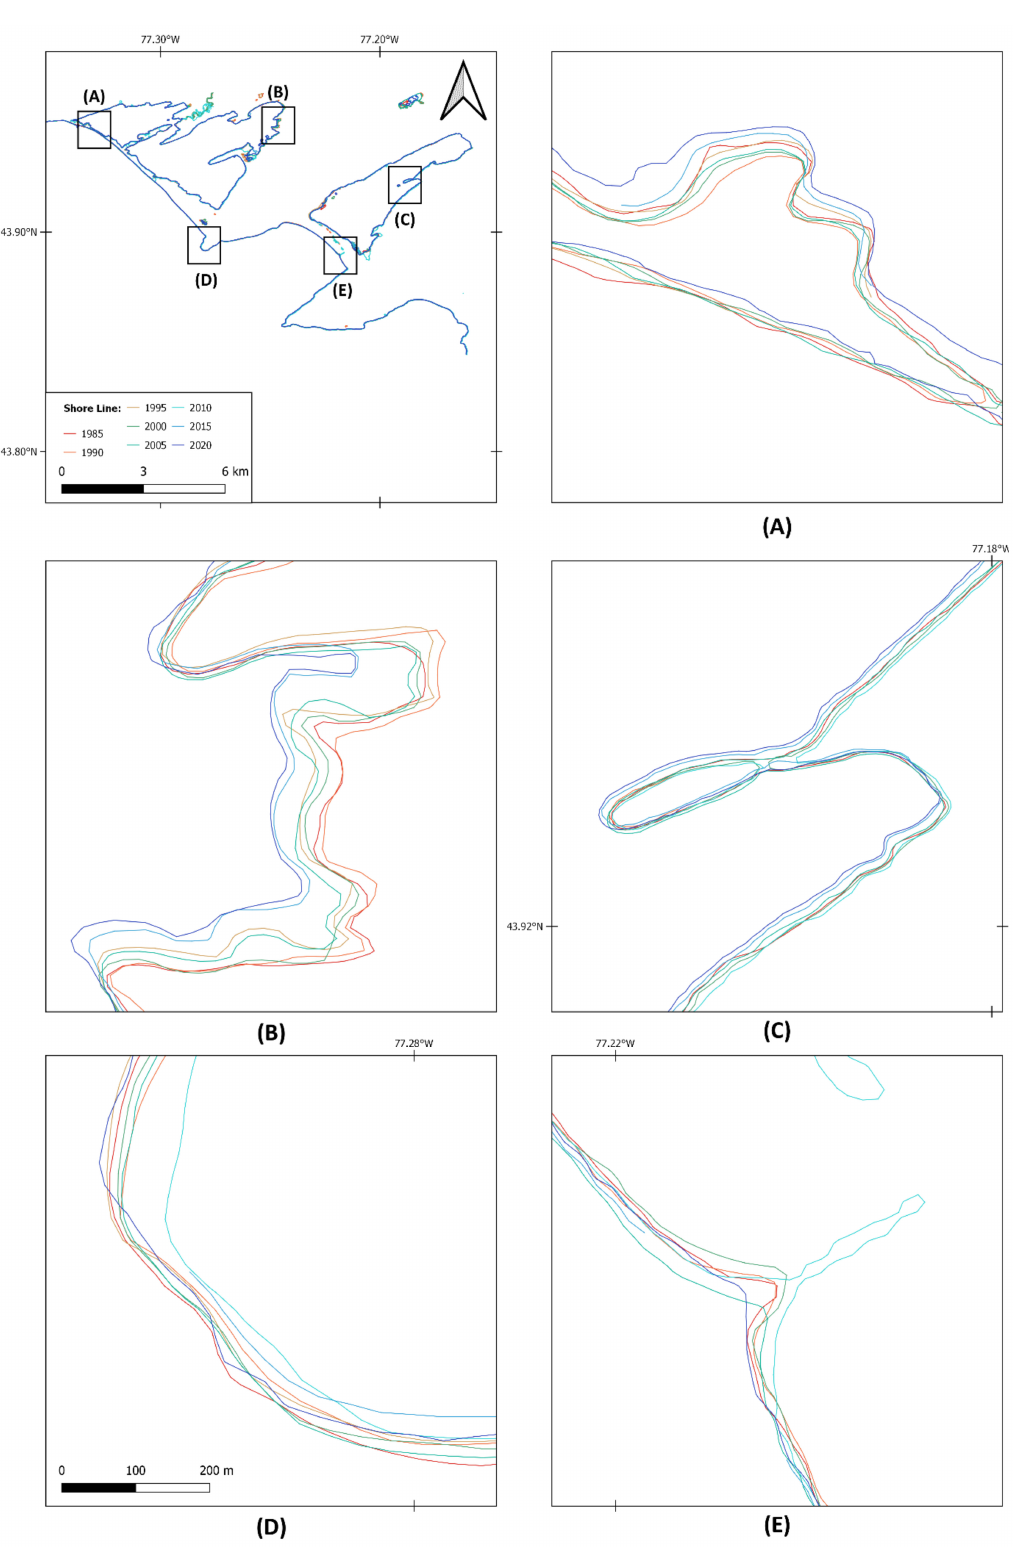
Figure 5. Shoreline position changes from 1985 to 2020. Two parts are shown with more details from the adjacent Lake Ontario coasts ( D , E ), one part at the very end of the East Lake ( C ), one part at the eastern side of West Lake ( B ), and another zone at the narrow section of the baymouth dune between Lake Ontario and West Lake ( A